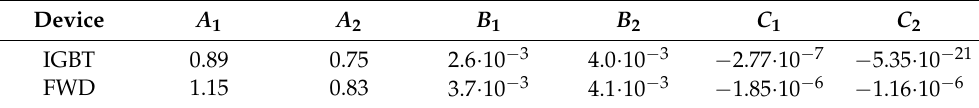
Table 6. Nominal values used in Equation